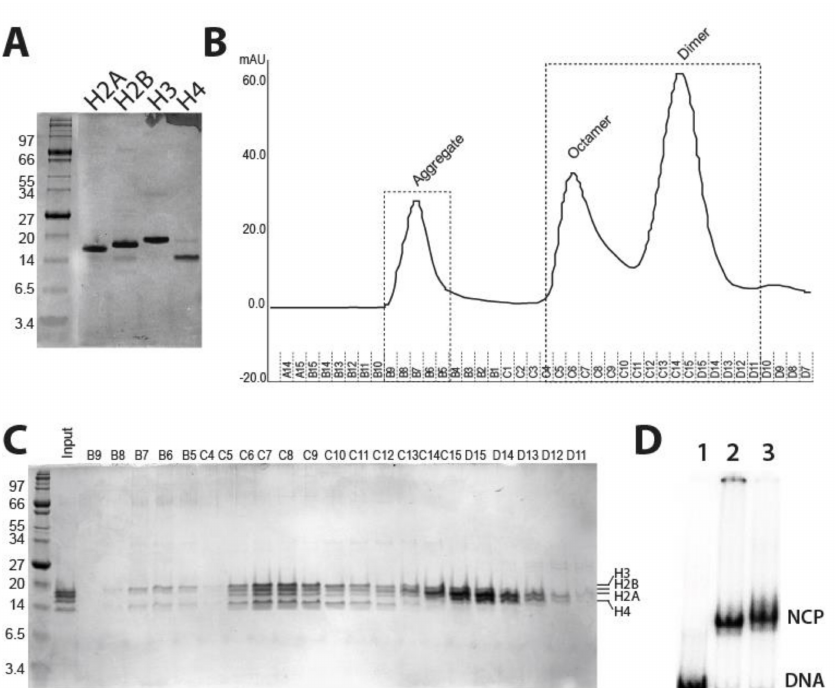
Figure 1. Purification of histone proteins, reconstitution of the histone octamer, and nucleosome core particles preparation: ( A ) Purified recombinant S. pombe histone proteins are separated on the denaturing 18% SDS-PAGE gel. ( B ) Refolded histone octamers were purified using the Superdex-200 gel exclusion column. The three peaks of aggregates, octamer, and dimers are shown. ( C ) Eluted protein fractions corresponding to three different peaks were separated on SDS-PAGE, Coomassie stained, quantified, and pooled (bottom panel). ( D ) Nucleosome core particle (NCP) on 601 PCR amplified DNA template having 70 bp of linker DNA (217 bp total length) with Xenopus histone (lane 2) and fission yeast octamer (lane 3), respectively, was reconstituted using salt dilution method and separated on 4% native PAGE